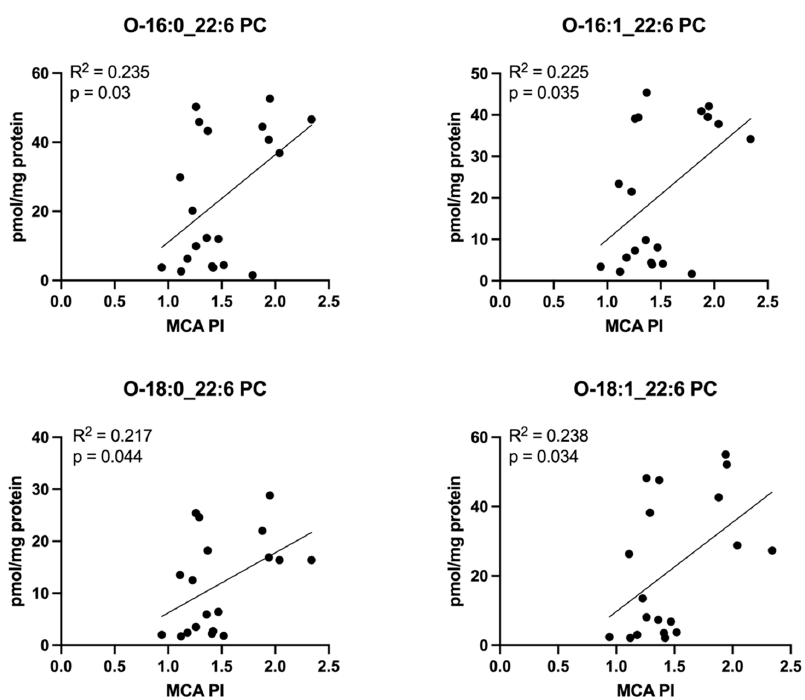
Figure 13. Correlations between MCA PI and concentrations of phosphatidylcholine molecules con- taining docosahexaenoic acid (DHA, 22:6) in the placenta. Scatterplots demonstrate direct correlation between middle cerebral artery pulsatility index (MCA PI) and placental concentrations of multiple phosphatidylcholine (PC) molecules containing DHA (22:6). “O-” denotes and ether linkage. Pearson correlation coefficient was computed to assess